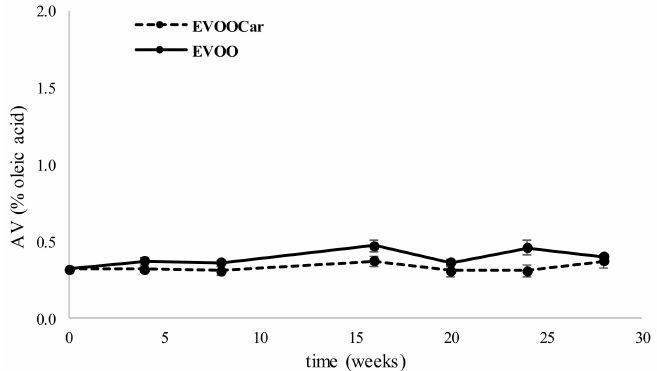
Figure 1. Trend of AV (% oleic acid, mean values) of extra virgin olive oil (EVOO) and carotenoid-enriched oil (EVOOCar) during long-term storage. Error bars refer to the standard deviations ( n =